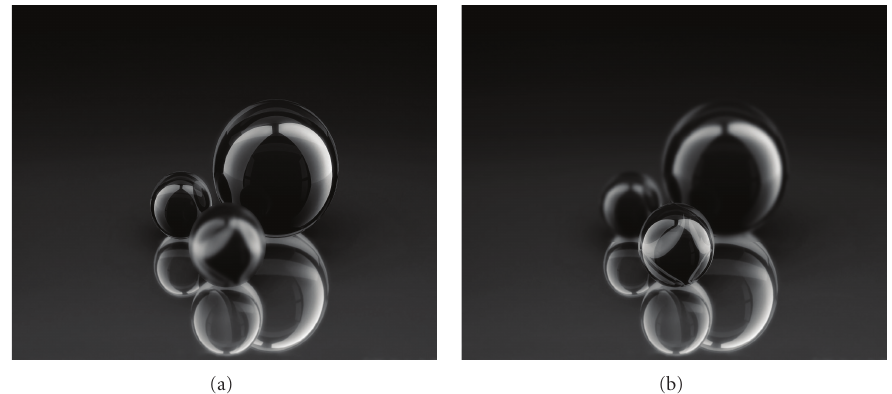
Figure 13: Two inputs of the image “Balls.” The central ball is blurred in (a) and vice versa, it is the only one sharp ball (b).